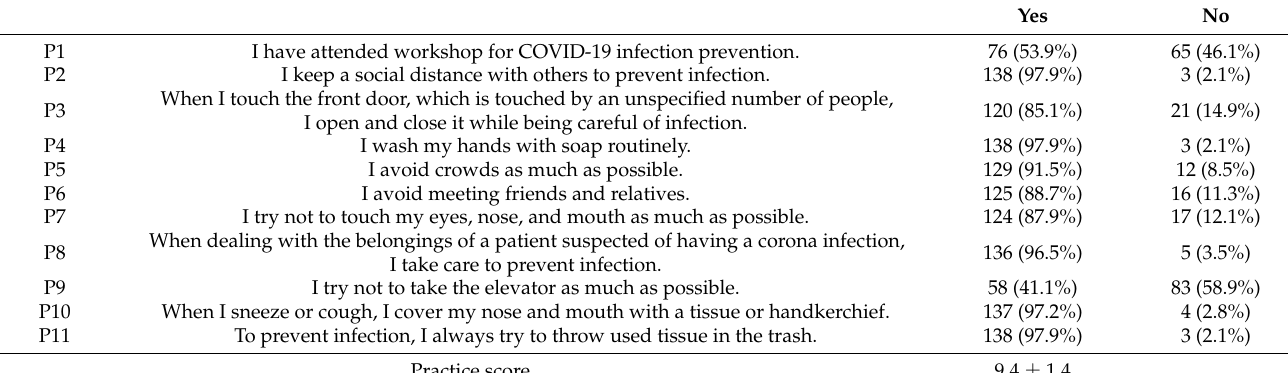
Table 4. Respondents’ answers on COVID-19